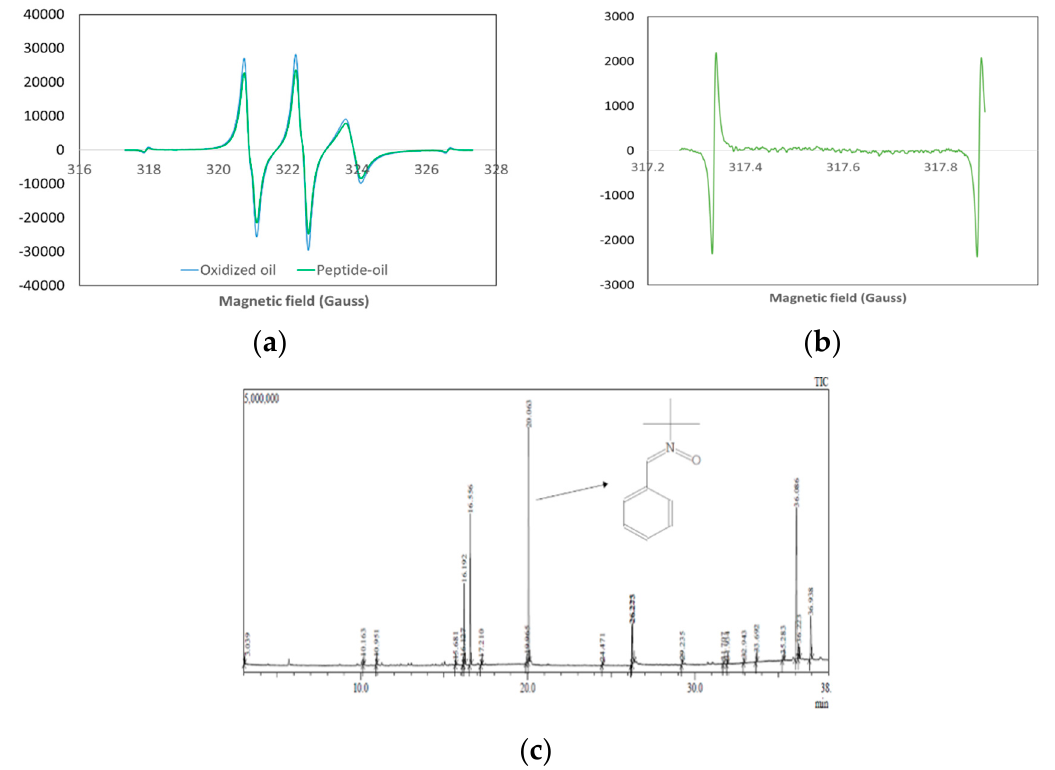
Figure 2. Effect of the peptide QITEGEDGGG against lipid radicals in oxidation oil. ( a ) ESR spectra of the PBN-radical adduct of walnut oil and peptide–oil during oxidation. ( b ) ESR signal of the heat-treated peptide solution. ( c ) GC-MS of the PBN-radical adduct in oxidized oil.